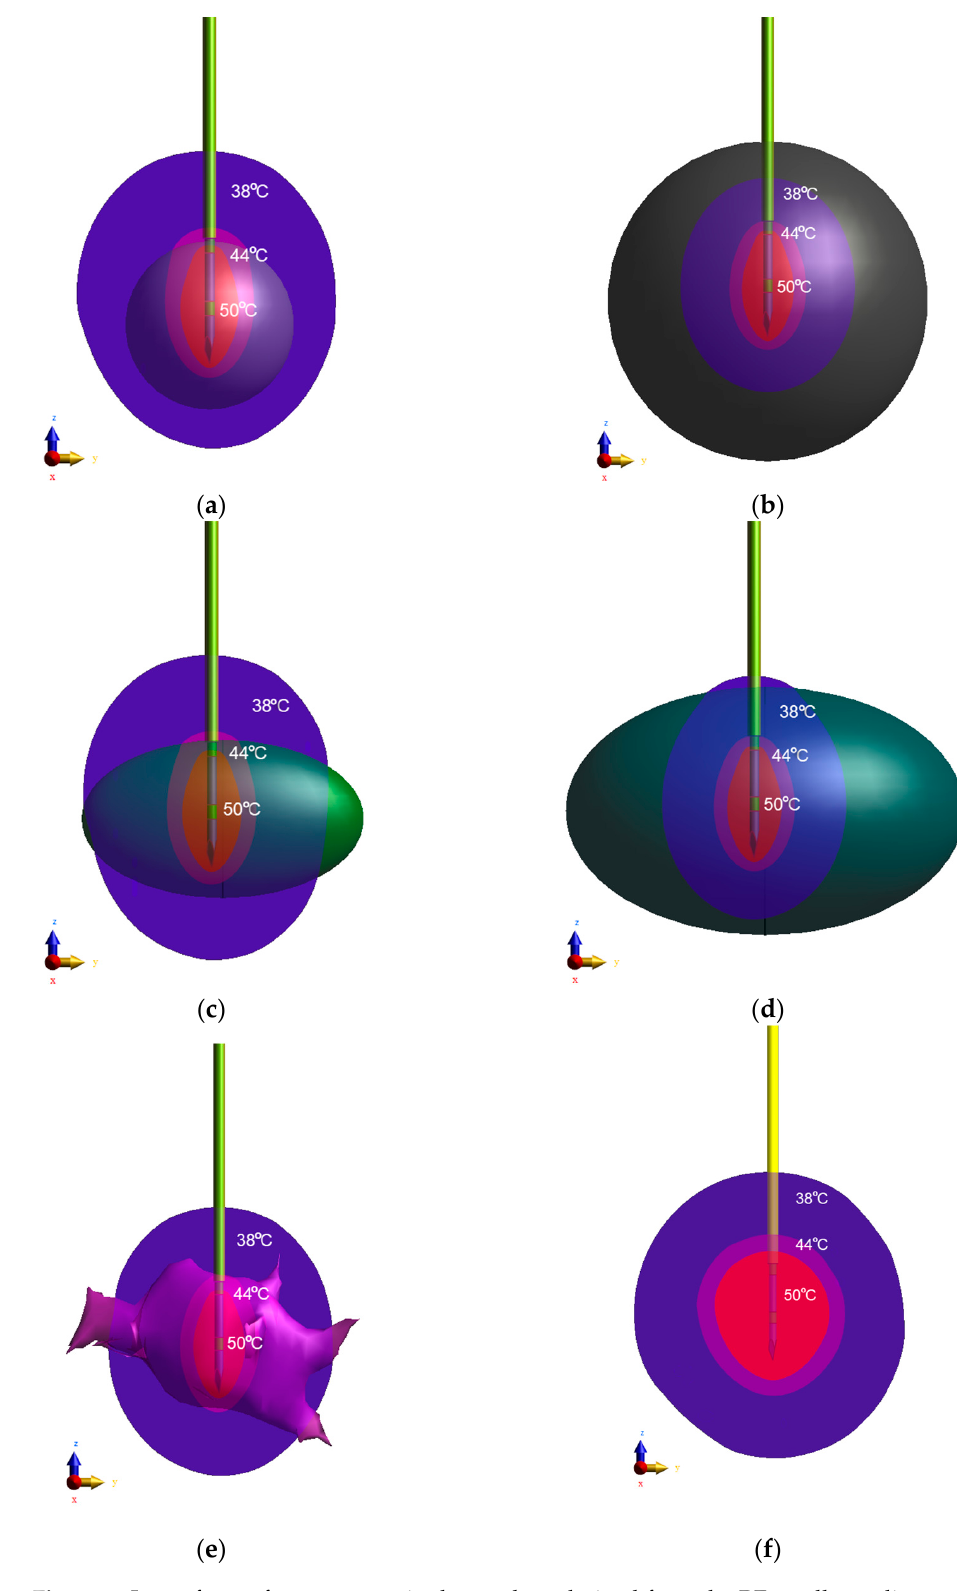
Figure 7. Isosurfaces of temperature in the yz plane derived from the RF needle applicator for all analyzed breast tumor equivalent models: ( a ) sphere S 1 ; ( b ) sphere S 2 ; ( c ) ellipsoid E 1 ; ( d ) ellipsoid E 2 ; ( e ) irregular tumor; ( f ) case without tumor.